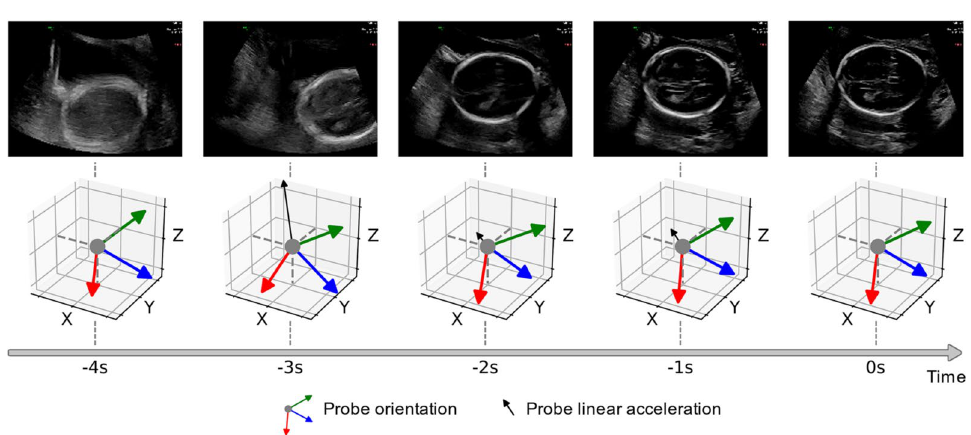
Figure 7. Example of transducer motion data. The figure displays the transducer motion data during the acquisition of the trans-ventricular (TV) standard biometry head and brain plane. The first row shows the ultrasound machine displayed frames (in 1-s intervals) before freezing (time = 0 s). The second row shows the corresponding transducer orientation and acceleration vector for each frame. Figure created using Python’s Matplotlib library 53 and Inkscape version 0.92 (https:// inksc ape.